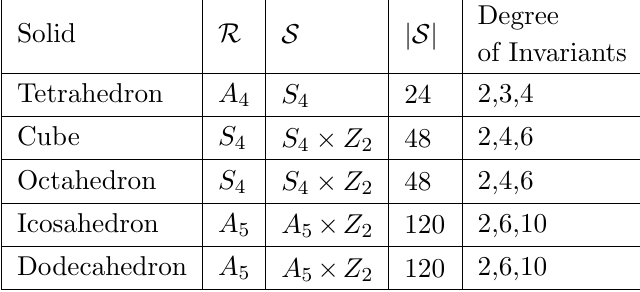
Table 2. The symmetries of (cid:12)ve Platonic solids. Group respectively. More colloquially, Platonic solid while try